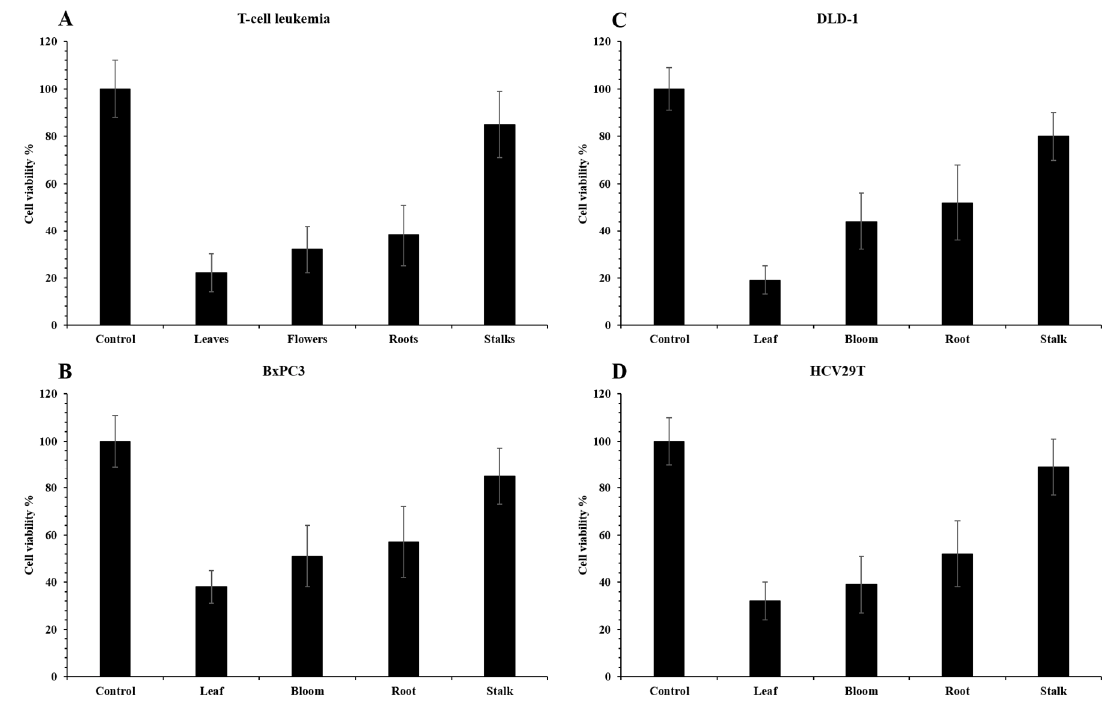
Figure 1. Cell viability of Jurkat ( A ), BxPC3 ( B ), DLD-1 ( C ), and HCV29T ( D ) cell lines after treatment with plant extracts for 48 h. Data are presented as means SD normalized to untreated control (1% ethanol).